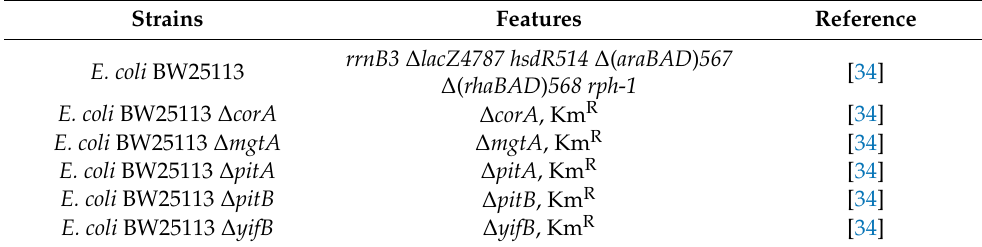
Table 1. Bacterial strains used in this